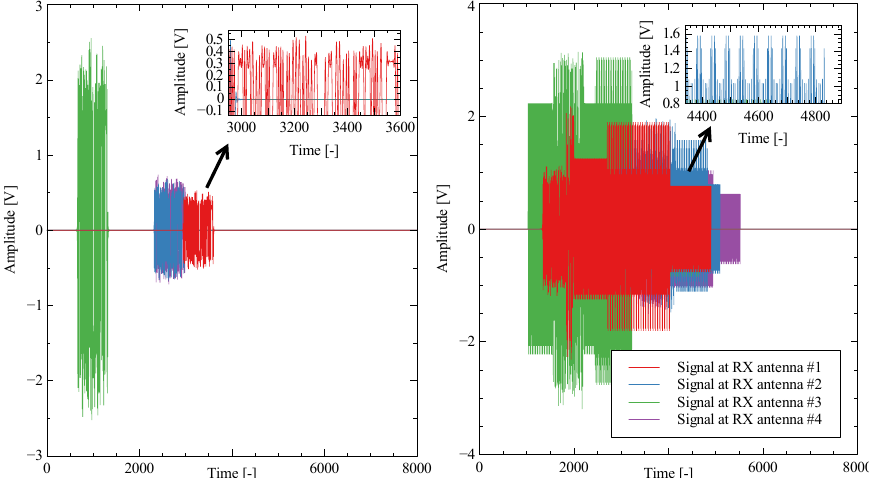
Figure 10. Example of the received signals. There is only one component from the quadrature receiver on four receiving antennas. Left : Signals without jamming. Right : Signals with randomly placed jamming devices.